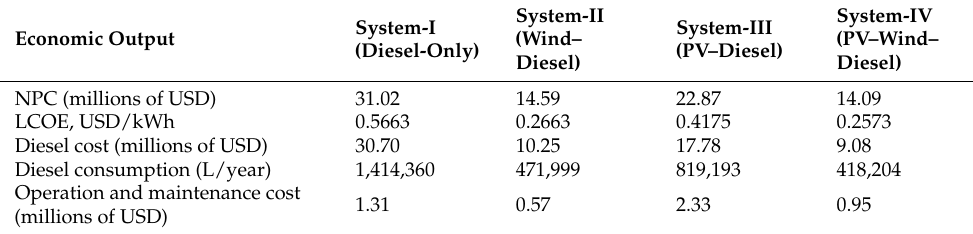
Table 8. Economic comparison for different optimal system